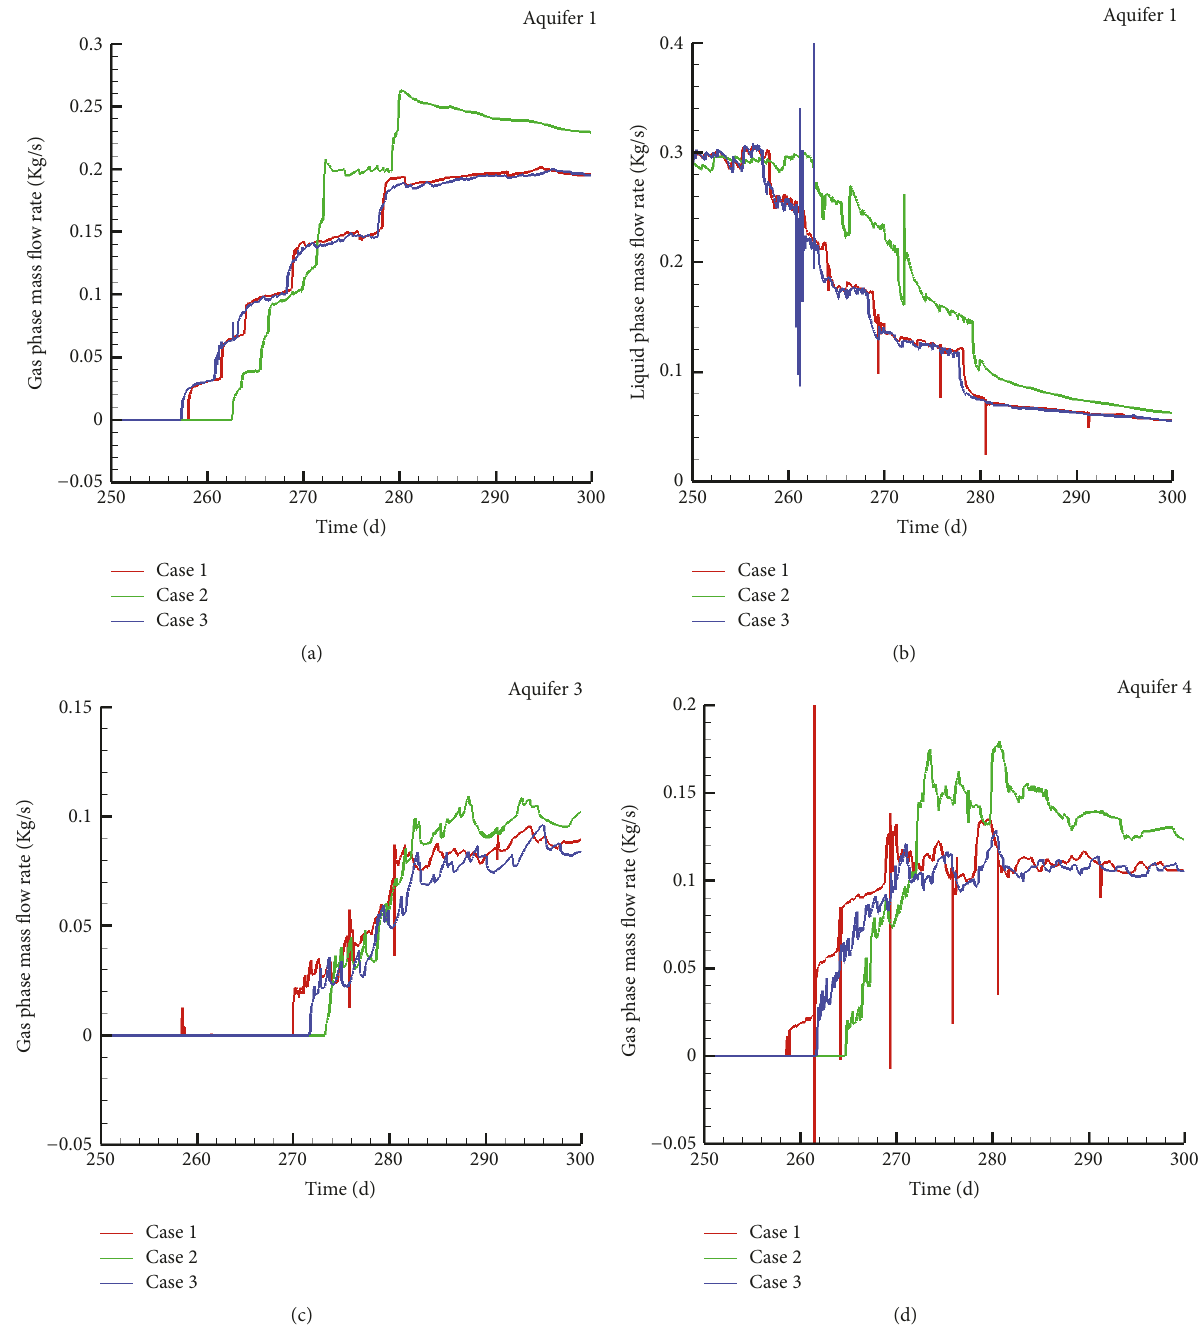
Figure 13: Fluids dynamics at the outlet/inlet of each aquifer in Cases 1–3 at early time (up to 300 days) after CO 2